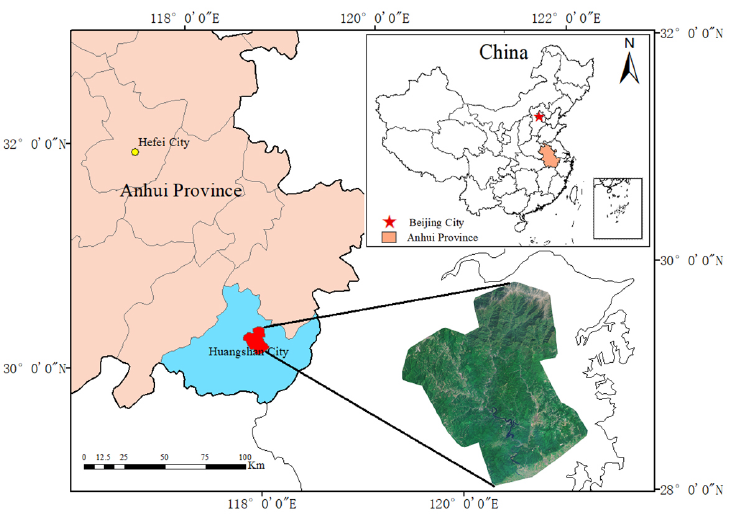
Figure 5. Geographic location and remote-sensing image of the study